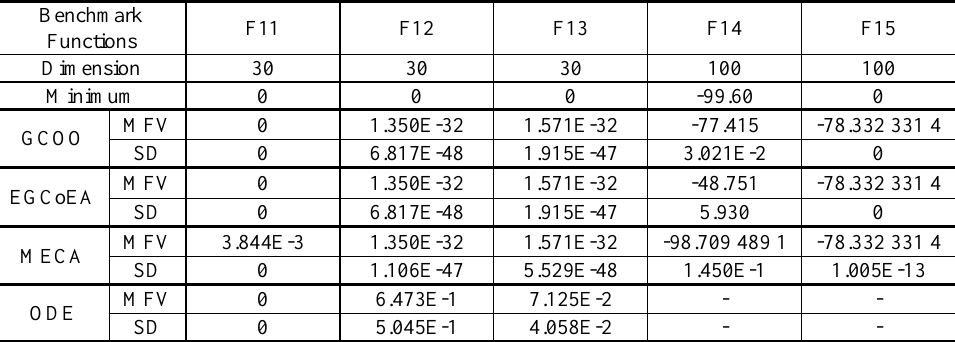
Experiments F11~F15